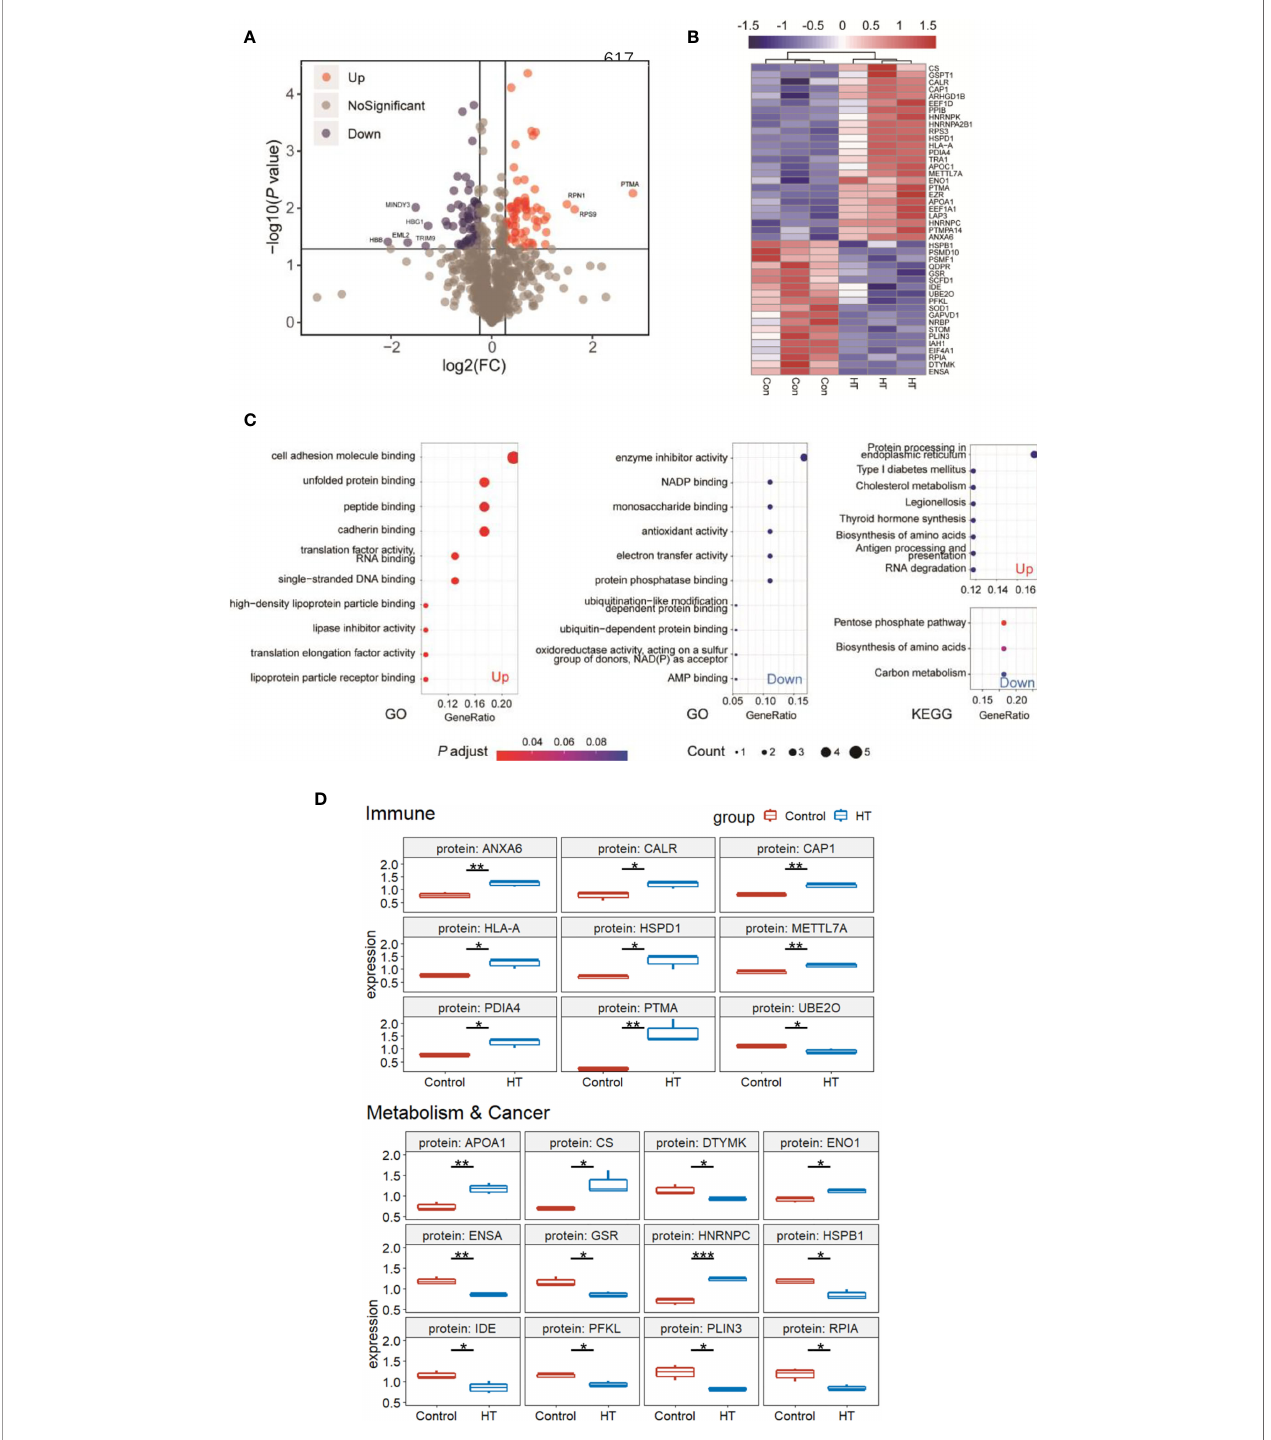
FIGURE 2 | Signi fi cant differences in protein expression between Hashimoto ’ s thyroiditis (HT) patients and healthy people. (A) Volcano plot of proteomic data. Volcano plots are depicted with the fold change of each protein, and the P -value was calculated by performing t-test. Red circles show proteins that have signi fi cant increases. Blue circles show proteins that have signi fi cant decreases. Gray circles are proteins without any differences. (B) Heat map of the 44 differentially expressed protein (DEPs) information. (C) GO and KEGG pathway analysis of 26 upregulated and 18 downregulated genes. (D) Summary of DEPs in key functional groups that show differences between HT and Control. DEPs related to the immune system and metabolism&cancer are shown in boxplots. Median value was marked. * P <0.05; ** P <0.01; *** P